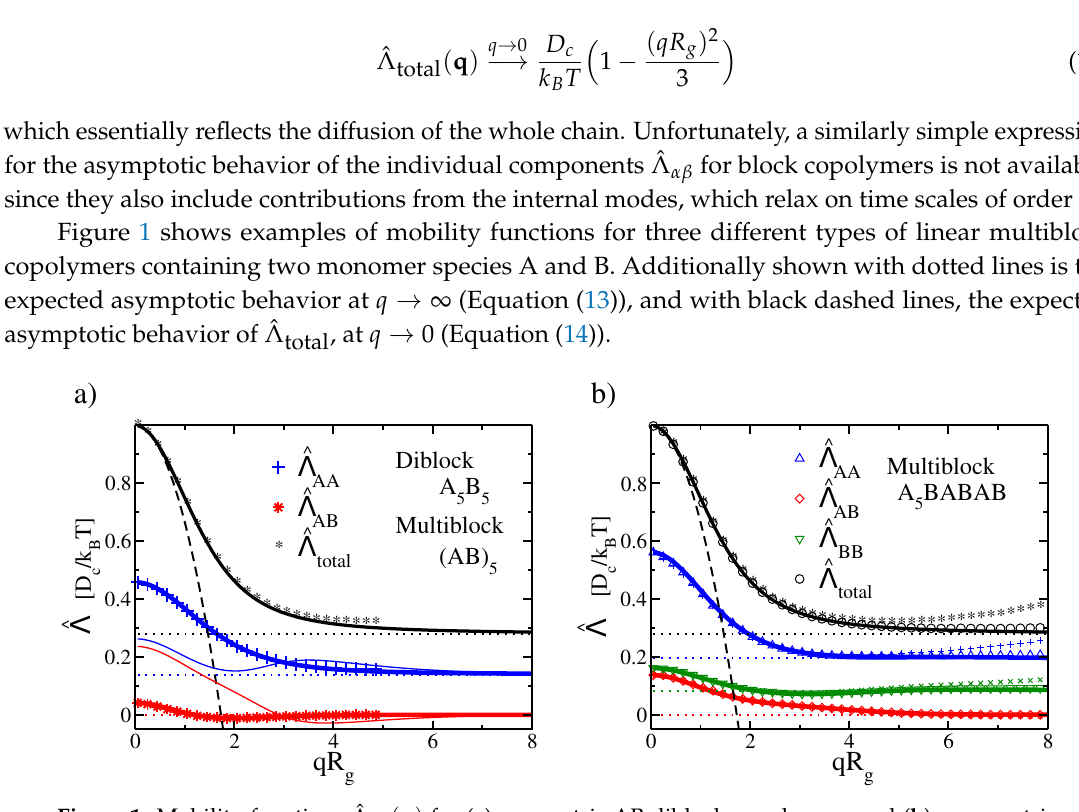
( q ) for ( a ) symmetric AB diblock copolymers and ( b ) asymmetric Figure 1. Mobility functions ˆ Λ αβ multiblock copolymers with sequence A 5 m B m A m B m A m B m . Thick solid lines show the theoretical results from Equation (4) with Equation (6). Symbols show simulation results from particle-based simulations of chains with length N = 40 (plus and stars) and N = 100 (circles, triangles and diamond). Dotted lines show the limiting behavior at q ∞ according to Equation (13), dashed line shows → limiting behavior Equation (14) of the total mobility function at q 0. For comparison thin lines in → ( a ) also show mobility functions for a symmetric multiblock with sequence (A m B m ) 5